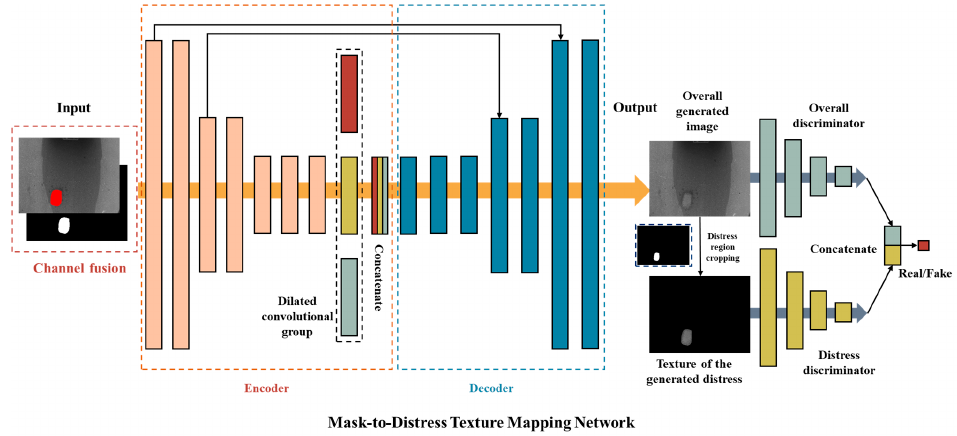
Figure 11. The Overall Architecture of MDTMN.